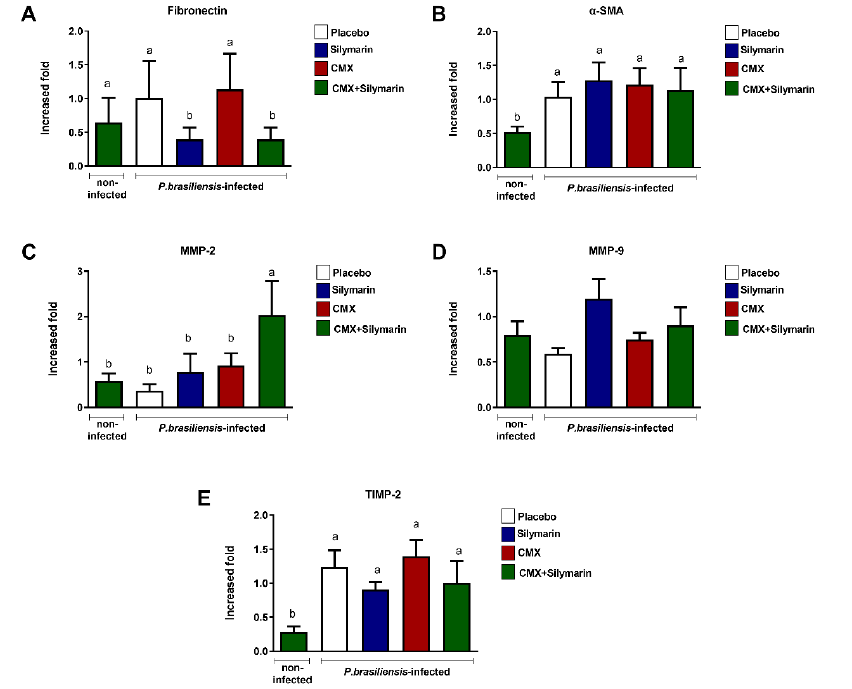
Figure 2. Influence of silymarin in combination with the antifungals cotrimoxazole (CMX) on the expression of components of extracellular matrix BALB/c mice were infected with P. brasiliensis , and at the 8th week of infection, silymarin/CMX schedule and placebo were started. The mice were eval- uated after 12 weeks of treatment for: ( A ) fibronectin, ( B ) α -SMA, ( C ) MMP-2, ( D ) MMP-9, ( E ) and TIMP-2. ANOVA with Tukey post hoc test; the values with different superscript letters in a column are significantly different ( p < 0.05); n = 5–7.